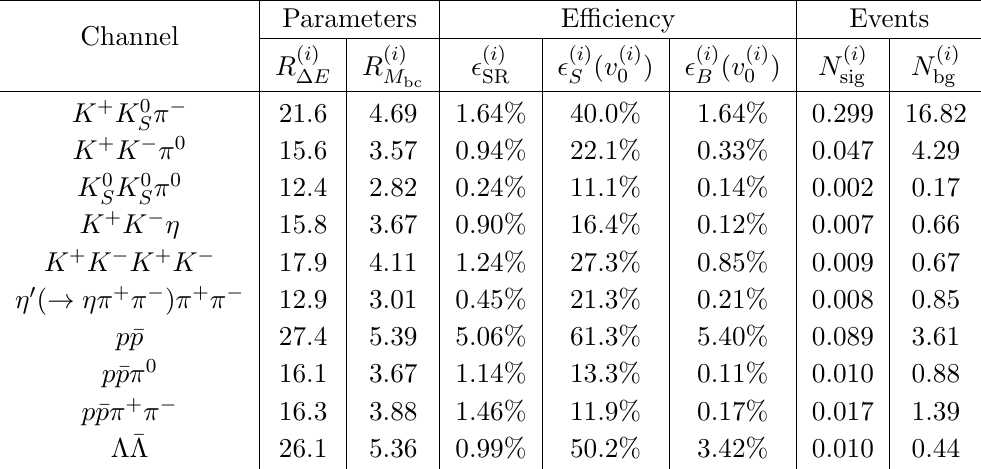
Results of the optimization of the selection requirements for the channel The expected number of signal events is calculated